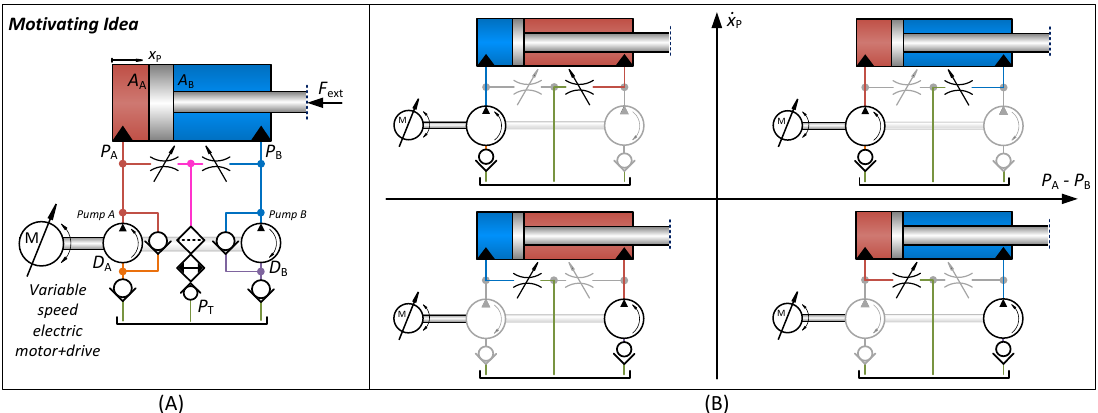
Figure 2. ( A ) Self-locking pump drive concept. ( B ) Four quadrant illustration of the intended basic drive